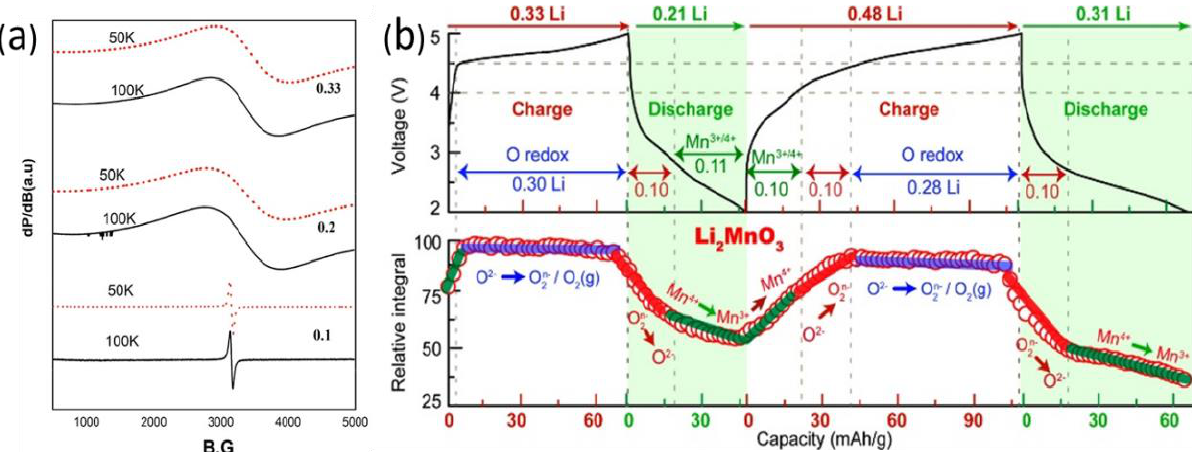
Figure 3. ( a ). EPR test of LiNi x Co 1−2x Mn x O 2 at 50K and 100K. From top to bottom x is equal to 0.33, 0.2, 0.1, respectively. (The Mn 4+ (t 2g3 e g0 ) signal is shown here in X band.) Panel ( a ) is reproduced with EPR signal integral with charge-discharge voltage in a Li 2 MnO 3 /Li half-cell. Mn 4+ ↔ Mn 3+